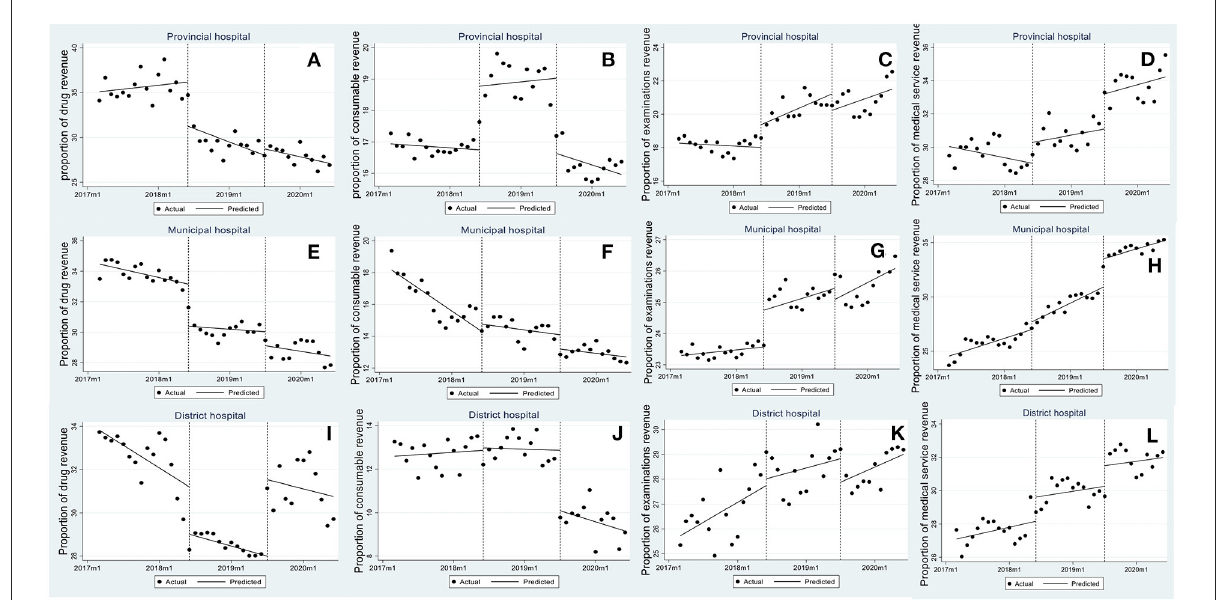
FIGURE1 Trend in monthly revenue structure in provincial, municipal and district hospitals. (A–D) Proportion of drug revenue, consumables revenue, examinations revenue, and medical service revenue in provincial hospitals, (E–H) proportion of drug revenue, consumables revenue,